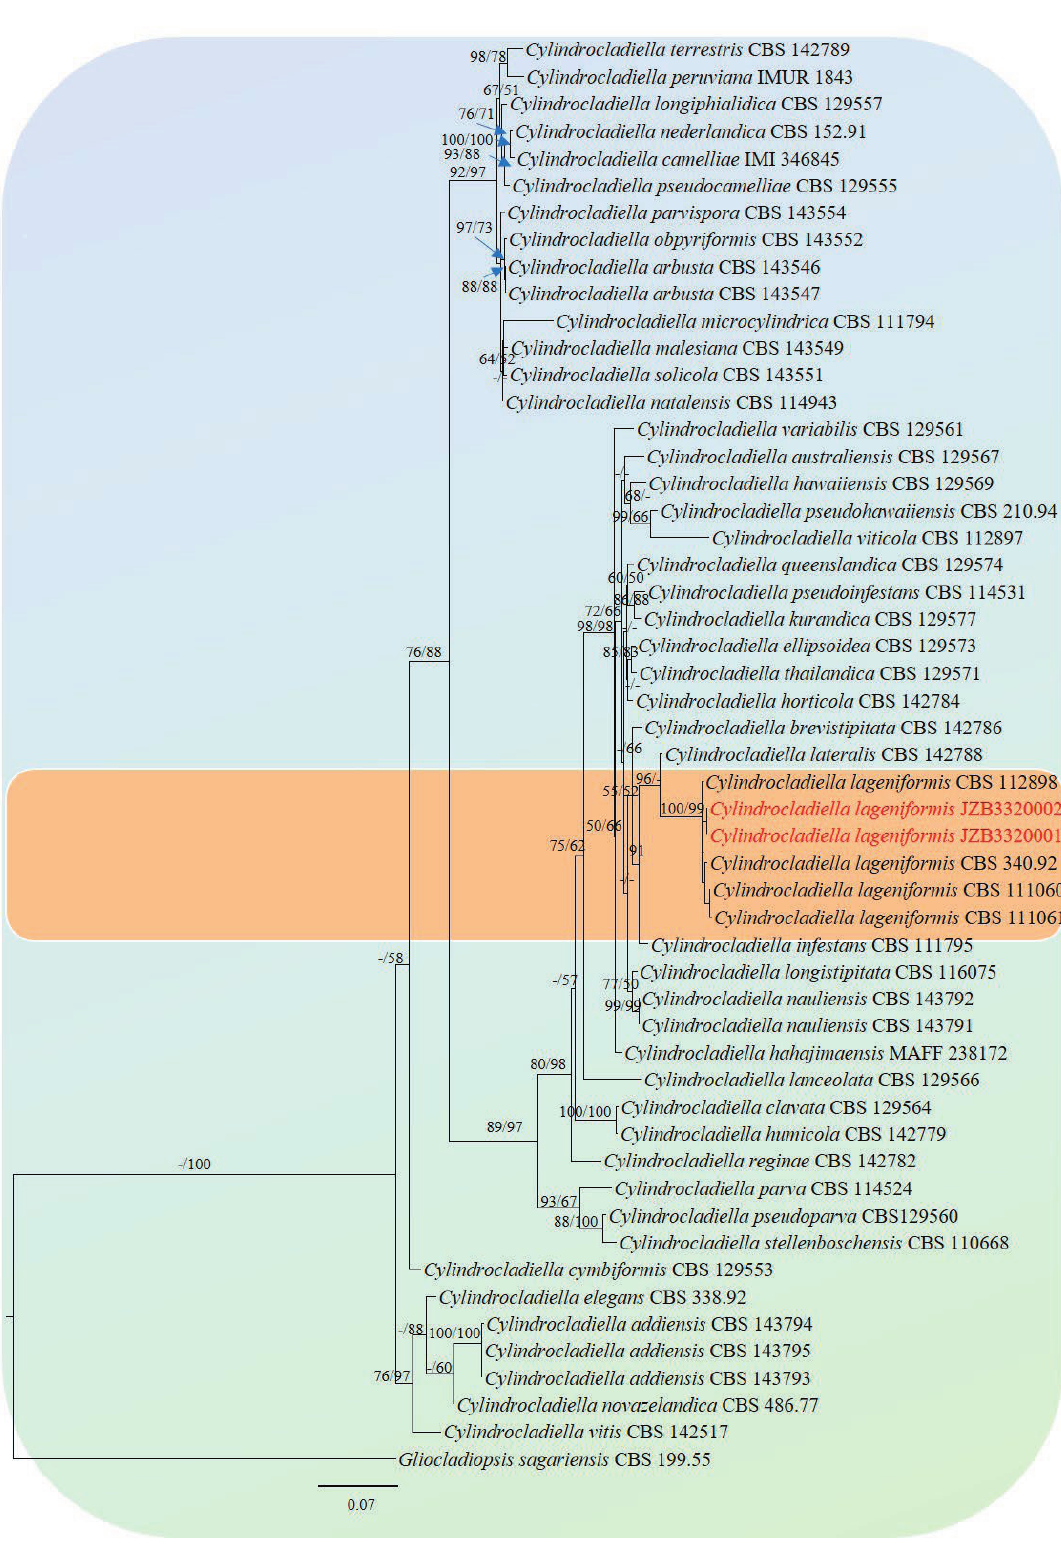
Figure 2. Maximum likelihood tree obtained from the phylogenetic analysis based on tef1 , his3 and tub2 sequence alignments. The scale bar represents 0.07 changes. The tree is rooted in Gliocladiopsis sagariensis (CBS